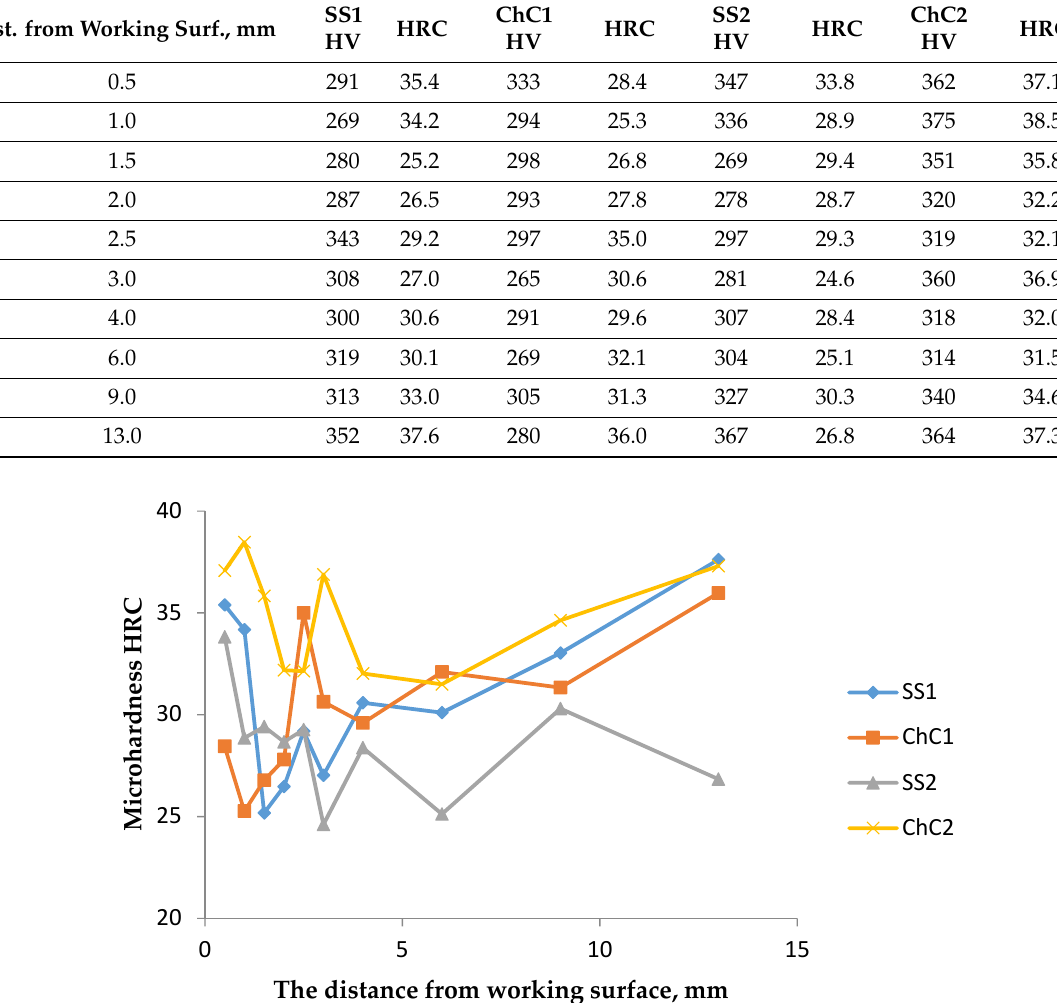
Figure 13. The relationship between HRC microhardness and distance of measurement point from the contact working surface.